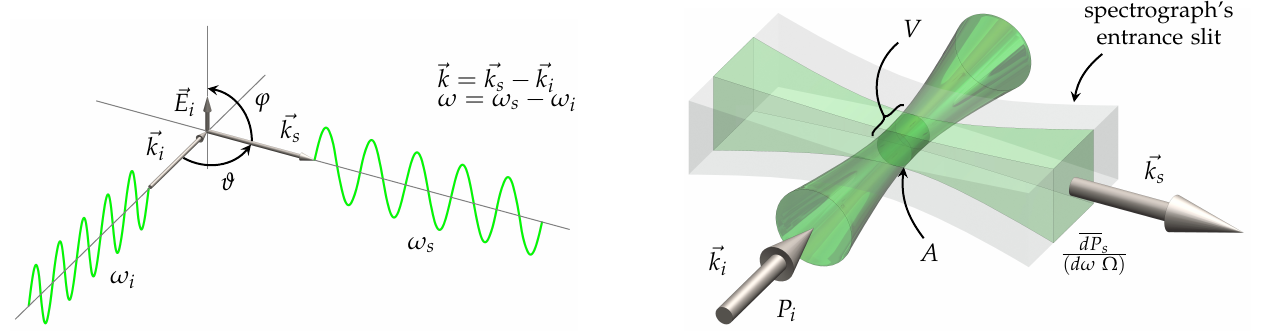
Figure 1. Scattering geometry used in this work. The angle ϕ = 90° is chosen to maximize the scattered intensity, whereas the scattering angle ϑ = 90° is chosen to acquire an incoherent scattering scattered intensity, whereas the scattering angle ϑ = 90° is chosen to acquire an incoherent scattering signal. The incident power P i of the laser beam is distributed across an area A which defines the signal. The incident power P i of the laser beam is distributed across an area A , which defines the scattering volume V . The detection apparatus records the mean scattered power dP s over a spectral scattering volume V . The detection apparatus records the mean scattered power dP s over a spectral frequency range d ω observed through solid angle Ω frequency range d ω observed through solid angle Ω